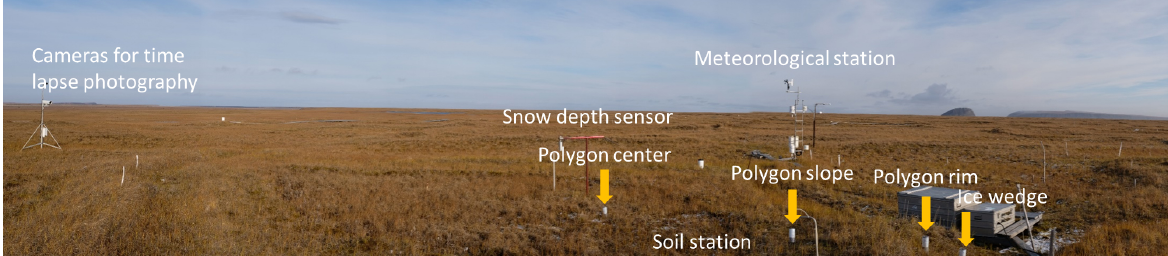
Figure B8. Meteorological station and soil station (consisting of sensors installed along 1-D profiles within polygon centre, rim, slope, and ice wedge) with cameras for time-lapse photography pointing towards both stations for snow and surface observations.